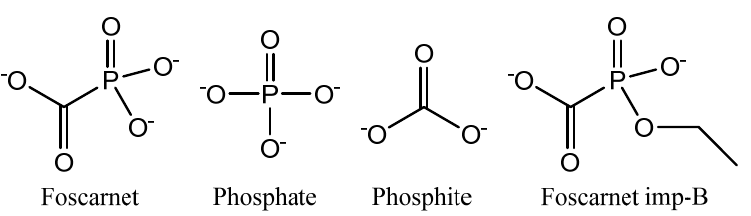
Figure 1. Foscarnet and related compounds, shown in their fully ionized forms without counterions.